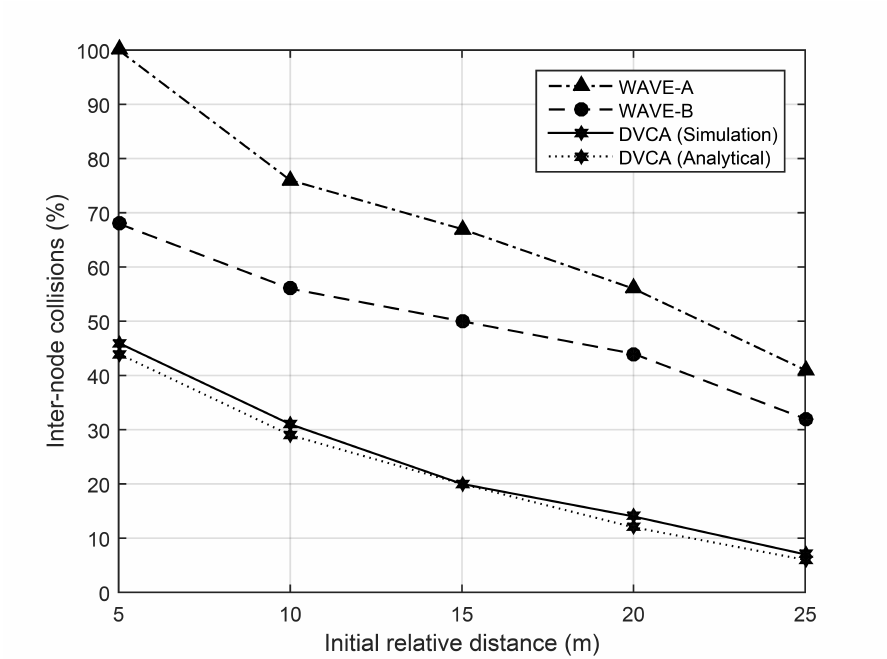
Figure 14. The effect of relative distance on